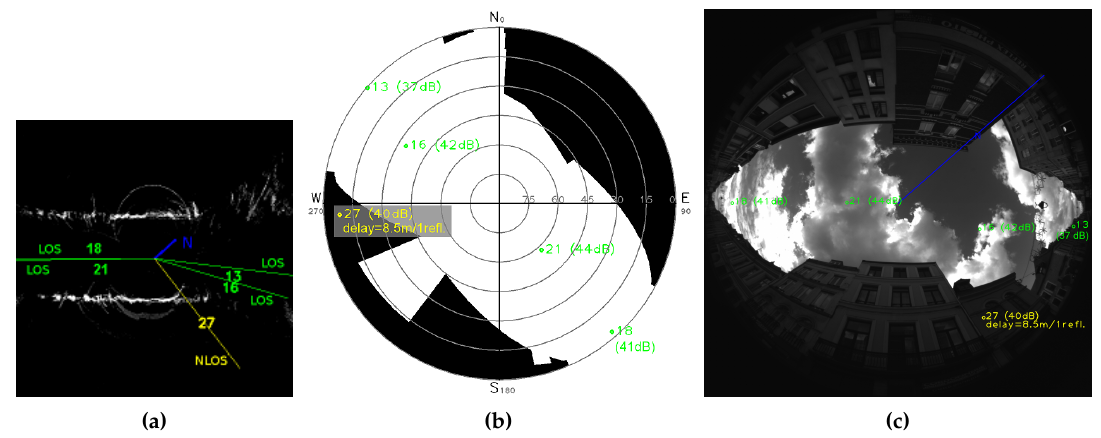
Figure 19. Instant 22 of acquisition Cap3/0900, pictures with satellites status given by the visibility mask method. The blue line indicates geographic North. LOS receptions are in green. NLOS receptions are in yellow with delay estimation. ( a ) Ground map with direct rays; ( b ) Skyplot and visibility mask; ( c ) Fisheye picture with satellites.